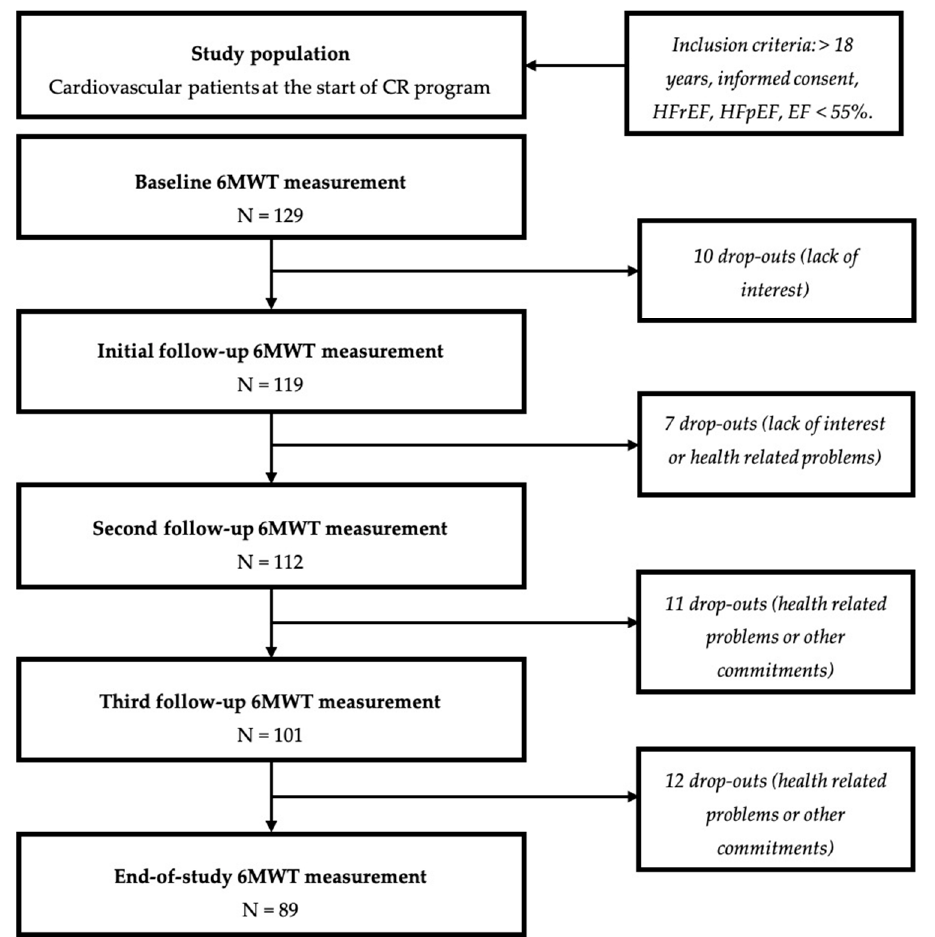
Figure A1. Study population flow chart.